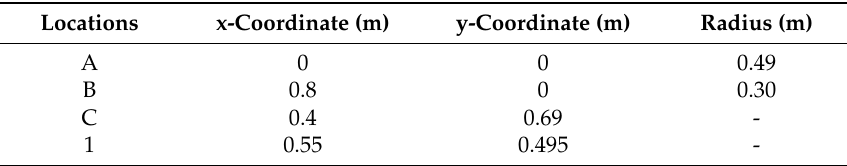
Table 2. Initial data of the first case study.